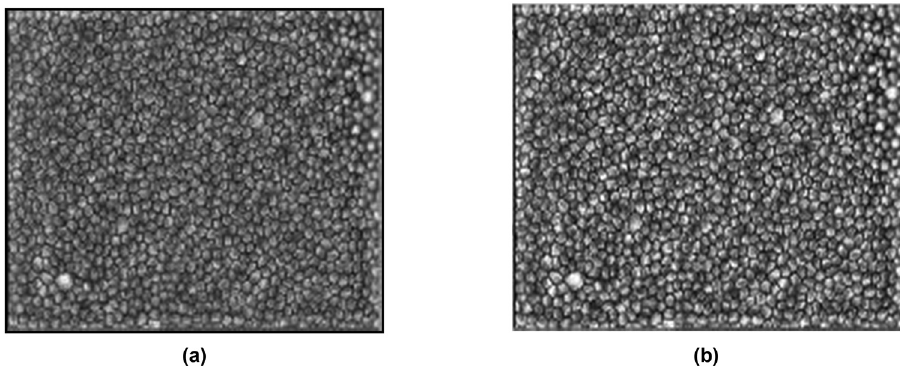
Figure 11: Depicts the e ff ects of using the moving - average technique and CLAHE fi lter for two cases a and